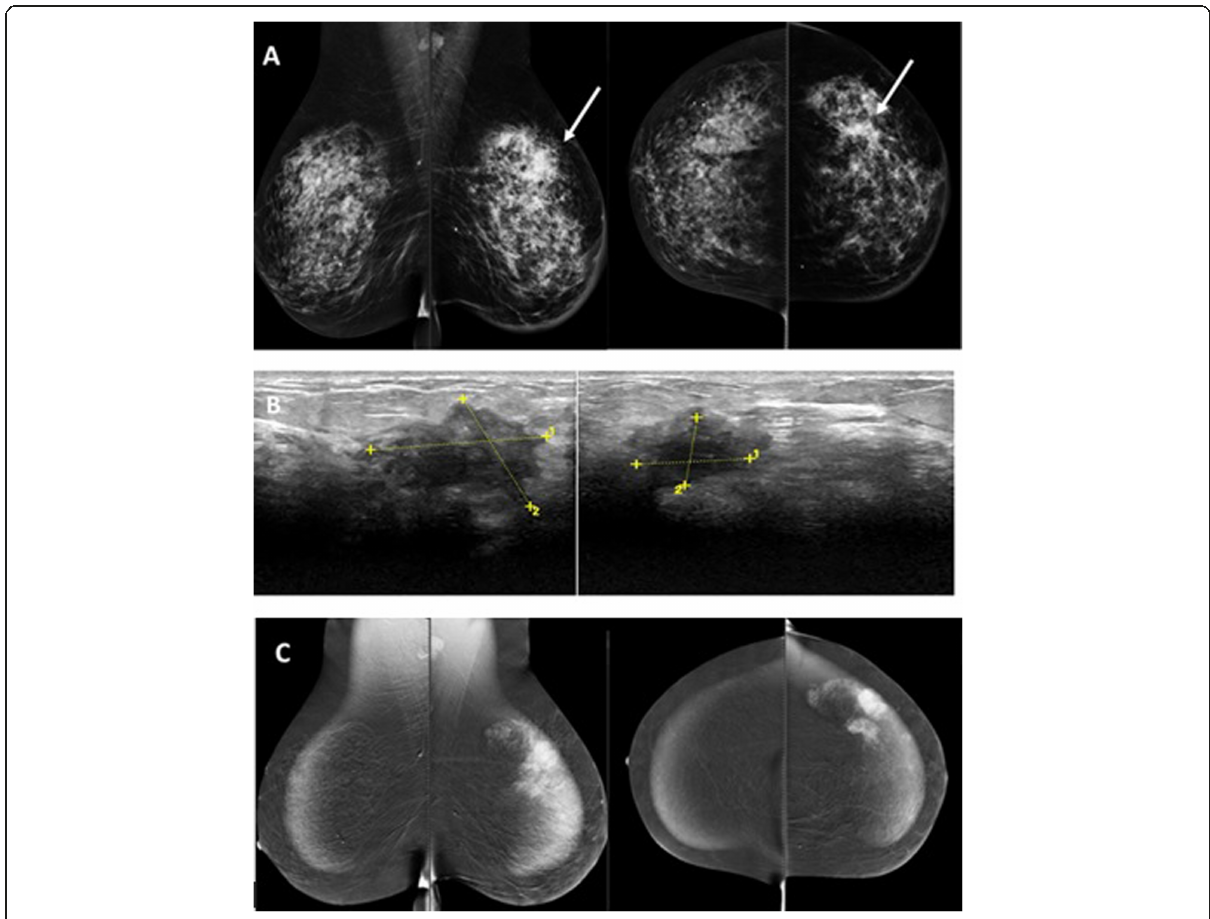
Fig. 3 Focal asymmetry associated with diffuse skin thickening (arrow) in a heterogeneous dense parenchyma seen in CC and MLO views ( a ). An evident underlying malignant ultrasound correlate was seen ( b ). CESM was performed to identify the actual extent of the malignant lesion ( c ). Wider tumor extension was identified on the contrast images. Biopsy revealed